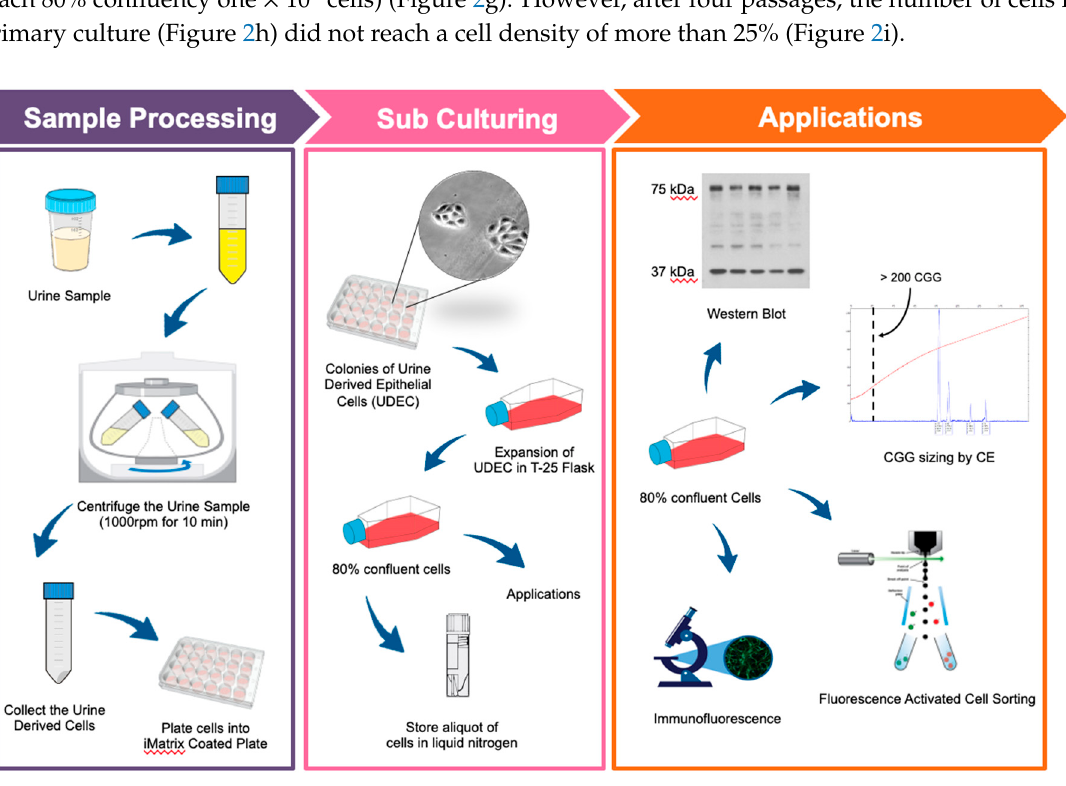
Figure 1. Schematic representation of the urine-derived epithelial cell culture establishment protocol. For sample processing, a urine sample was collected, transferred into a sterile 50-mL centrifuge tube, and centrifuged at 1000 rpm for 10 min at room temperature. Collected urine-derived cells were plated into iMatrix coated wells and incubated at 37 °C for 24 h. Cells were fed until small colonies of approximately 5–6 cells appeared, which on average, took 2–3 weeks after plating to reach 80%–90% density. Cells were harvested, aliquoted, and stored in cryotubes in liquid nitrogen for different applications (Western Blots, CGG repeat sizing, Immunofluorescence, and Fluorescence-Activated Cell Sorting).